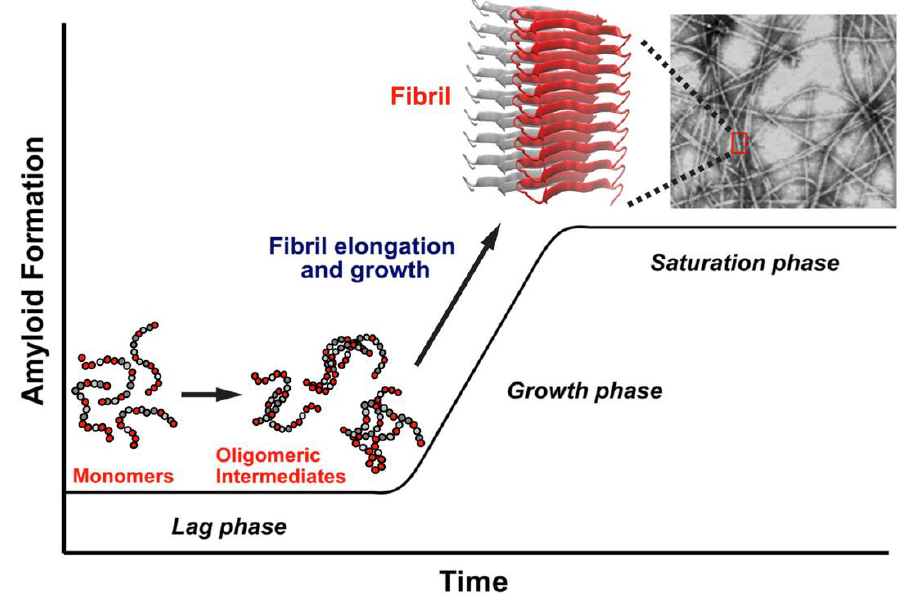
Figure 1. Schematic diagram of the kinetics of aggregation of human islet amyloid polypeptide (hIAPP). The early stages of aggregation (lag phase) involves the formation of disordered oligomers, followed by a rapid growth phase that leads to the formation of ordered fibrils, ending with a saturation phase when the fibrils have fully matured. Adapted from Abedini et al. [22]. Licensed under a Creative Commons Attribution (CC BY) license.